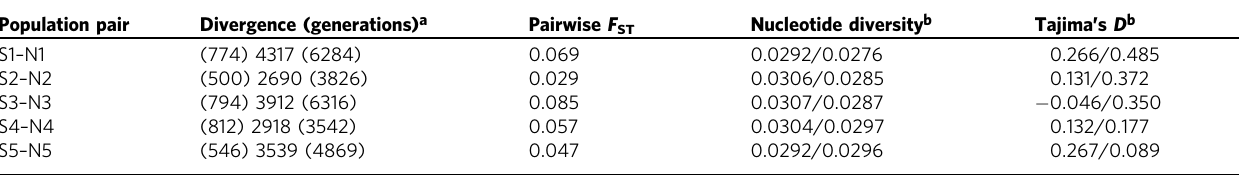
Table 1 Between-population divergence and within-population diversity of the fi ve investigated serpentine/non-serpentine population pairs inferred from genome-wide fourfold-degenerate single nucleotide